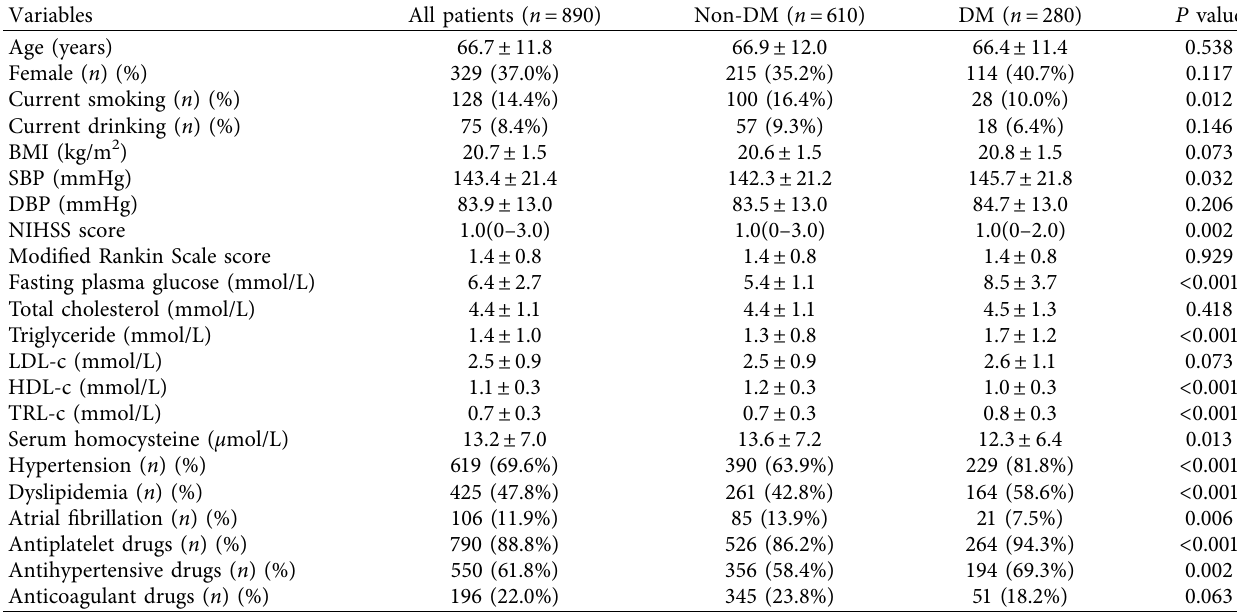
Table 1: Clinical characteristics of the study population.